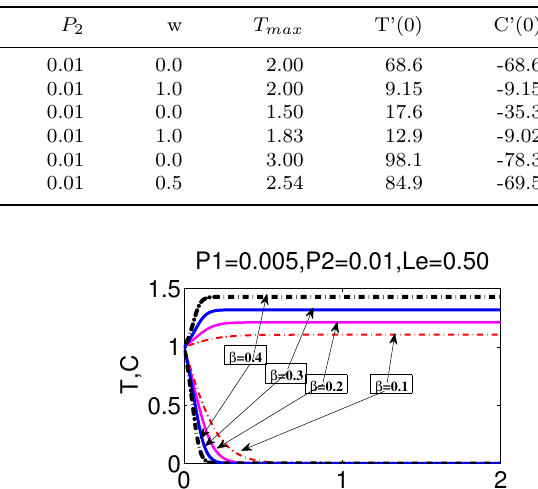
Table 2. The values of T max , T (cid:48) (0), C (cid:48) (0) depend on P 1 , P 2 , w